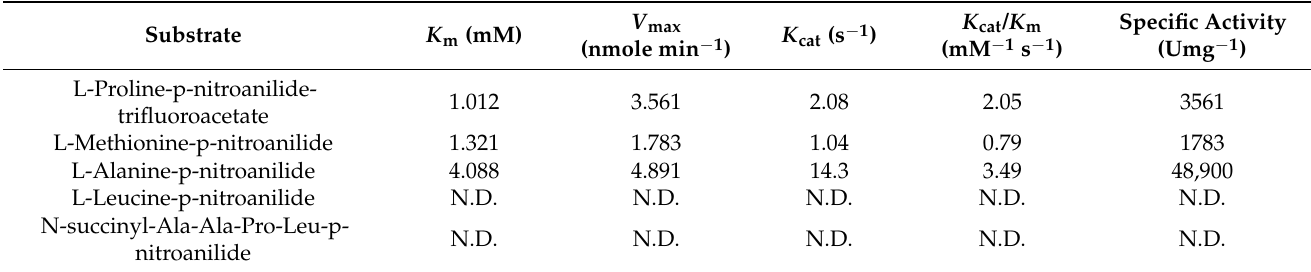
Table 1. Kinetic parameters of Ga PIP.